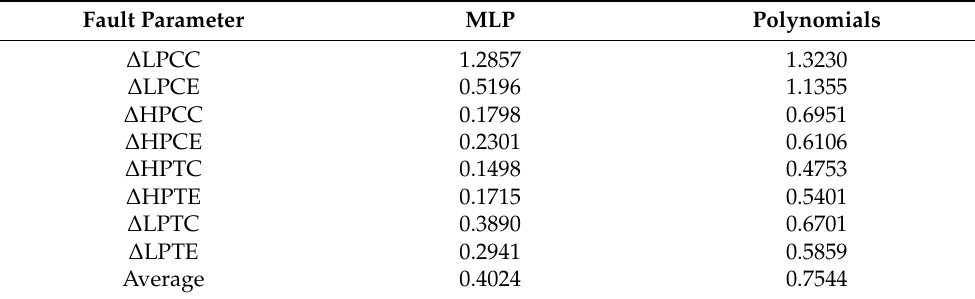
Table 10. Fault parameter RMSEs of MLP and polynomials (turbo